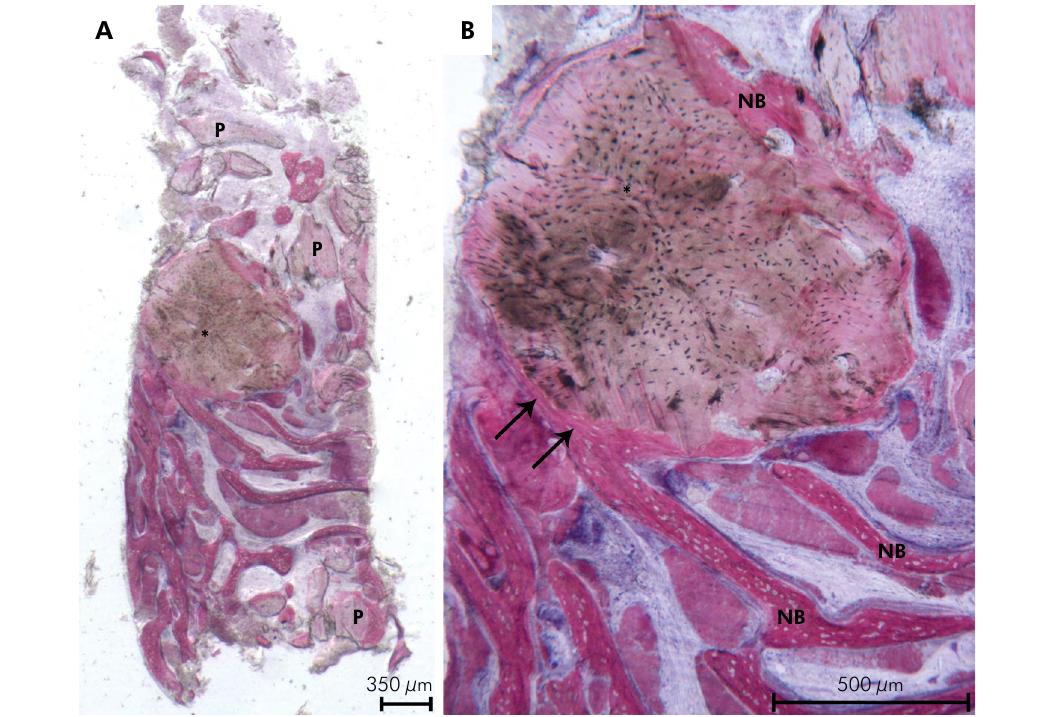
Figure 4. Low power magnification image of a Group 2 sample (autologous bone chips + porcine-derived xenogenic bone). (A) Newly formed trabecular bone with marrow spaces and residual bone chips (*) and porcine bone (P) particles were present (Toluidine blue and acid fuchsin, 12x); (B) an autologous bone particle (*) lined by newly formed bone (arrows) with wide osteocyte lacunae and areas of new bone formation (NB) could be seen. (Toluidine blue and acid fuchsin, 200 x).